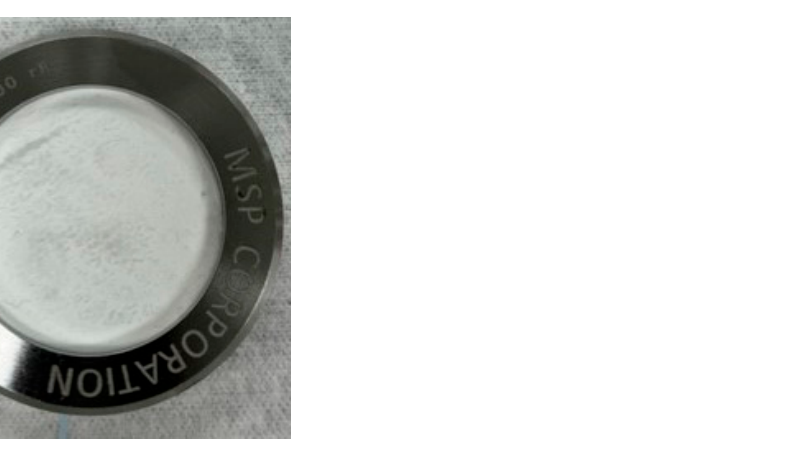
Figure 11. Filter casse tt e to keep the glass fi ber fi lter and the pre-soaked polycarbonate fi lter.